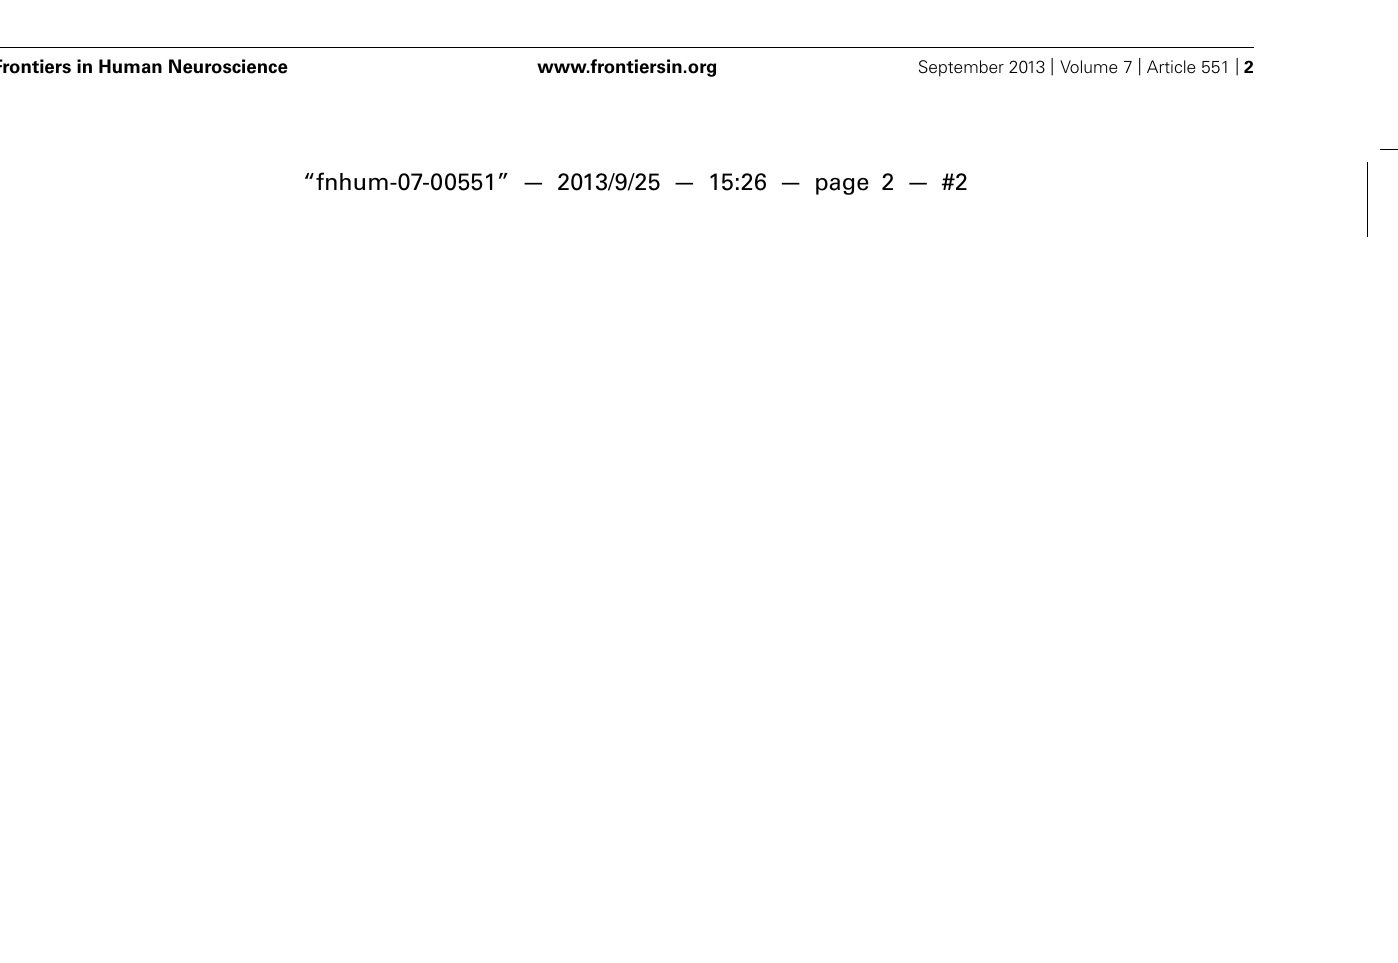
two fundamental dimensions of valence and arousal, which form an emotional space. In the dimensional theory, each emotional state may be continuously represented as a linear combination of values in these two dimensions.The original faces were drawn from Ekman and Friesen (1976), and Russell